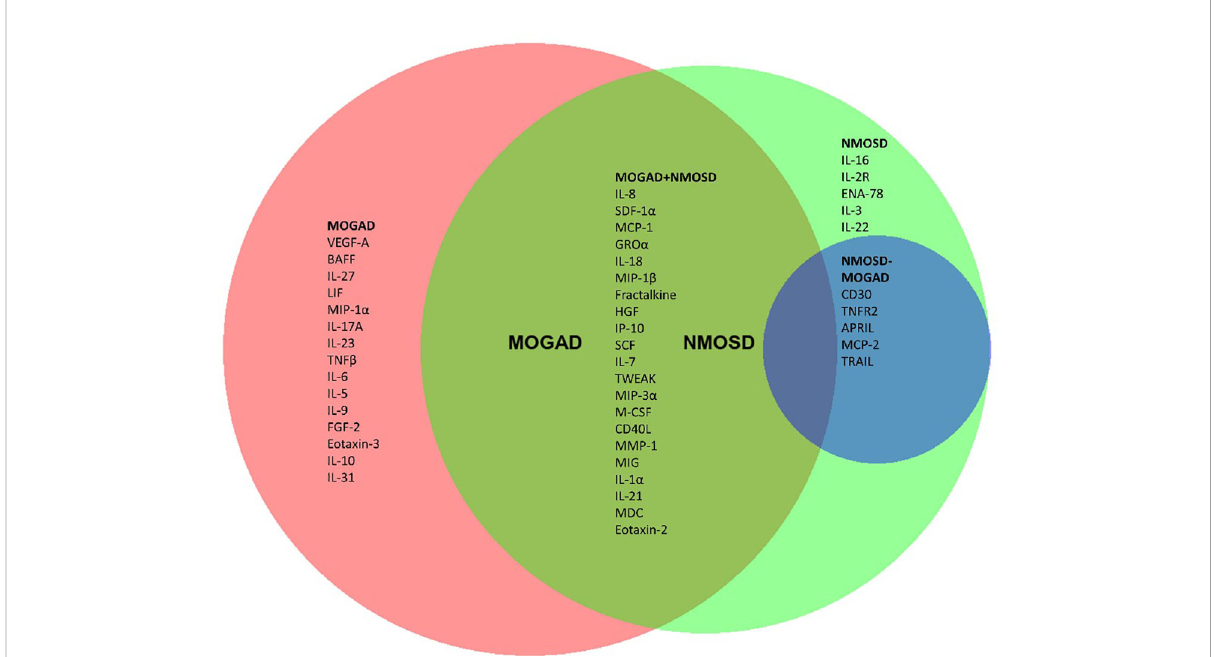
FIGURE 4 Cytokines, chemokines and related molecules signi fi cantly associated with MOGAD and/or NMOSD. (A) Venn diagram of signi fi cantly altered cytokines/chemokines/related molecules of pairwise Mann-Whitney U test comparison with MS patients. In red are those analytes which speci fi cally differed in MOGAD patients compared to MS. In the green circle are those that were signi fi cantly altered in NMOSD patients compared to MS. In the overlapping part labeled as MOGAD+NMOSD are those that signi fi cantly differed for both MOGAD and NMOSD compared to MS. The blue circle shows those cytokines/chemokines that signi fi cantly differed in the direct comparison of NMOSD with MOGAD. APRIL, a proliferation-inducing ligand; BAFF, B cell activation factor; BLC, B lymphocyte chemoattractant; CD40L, CD40 ligand; ENA-78, epithelial neutrophil-activating peptide-78; FGF, fi broblast growth factor; G-CSF, granulocyte colony-stimulating factor; GM-CSF, granulocyte-macrophage colony-stimulating factor; GRO, growth-regulated oncogene; HGF, hepatocyte growth factor; IFN, interferon; IL, interleukin; IP, interferon- ɣ -induced protein; I-TAC, interferon-inducible T cell a -chemoattractant; LIF, leukemia inhibitory factor; MCP, monocyte chemoattractant protein; M-CSF, macrophage colony-stimulating factor; MDC, macrophage-derived chemokine; MIF, macrophage migration inhibitory factor; MIG, monokine induced by interferon- ɣ ; MIP, macrophage in fl ammatory protein; MMP, matrix metalloproteinase; MOGAD, myelin oligodendrocyte glycoprotein associated disease; MS, multiple sclerosis; NGF, nerve growth factor; NMOSD, neuromyelitis optica spectrum disorder; SCF, stem cell factor; SDF, stromal cell-derived factor; TNF, tumor necrosis factor; TRAIL, TNF-related apoptosis- inducing ligand; TSLP, thymic stromal lymphopoietin; TWEAK, tumor necrosis factor-like weak inducer of apoptosis; VEGF, vascular endothelial growth